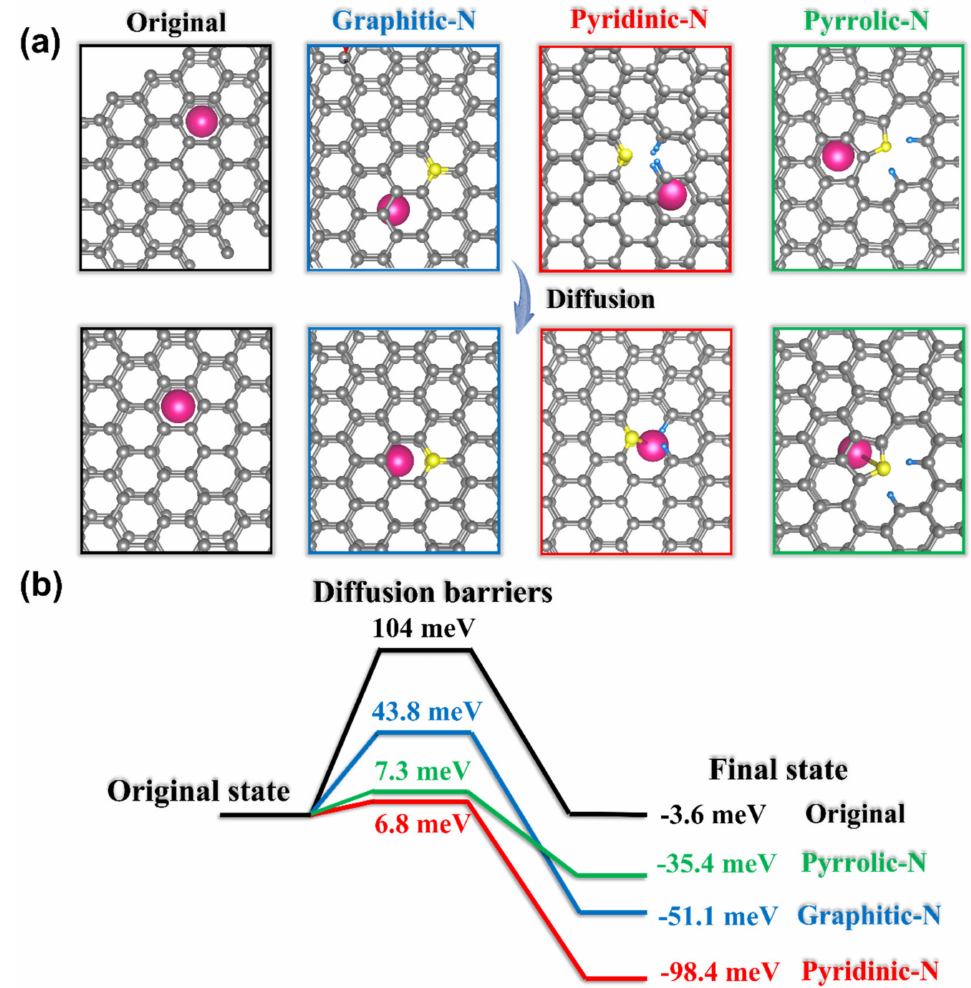
Figure 5. ( a ) DFT illustrations of K-ion diffusion, and ( b ) simulated diffusion barriers and thermody- namics across original hard carbon, graphitic-N, pyrindic-N, and pyrrolic-N